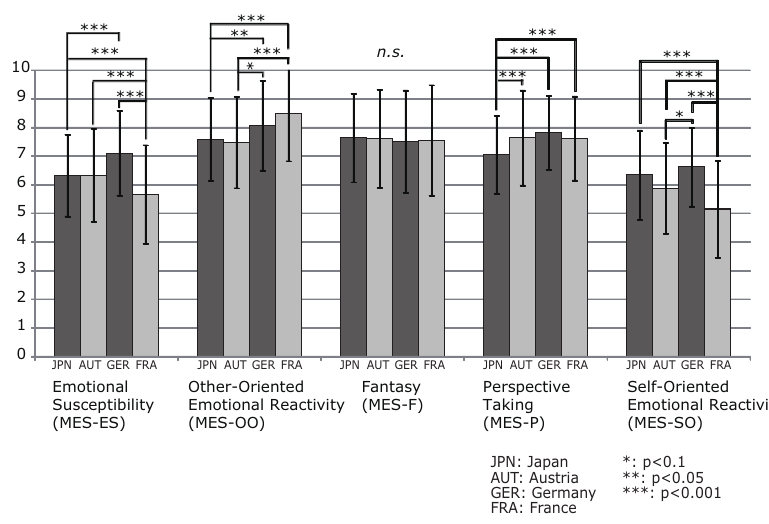
Figure 7. Scores for multidimensional empathy scale (MES).